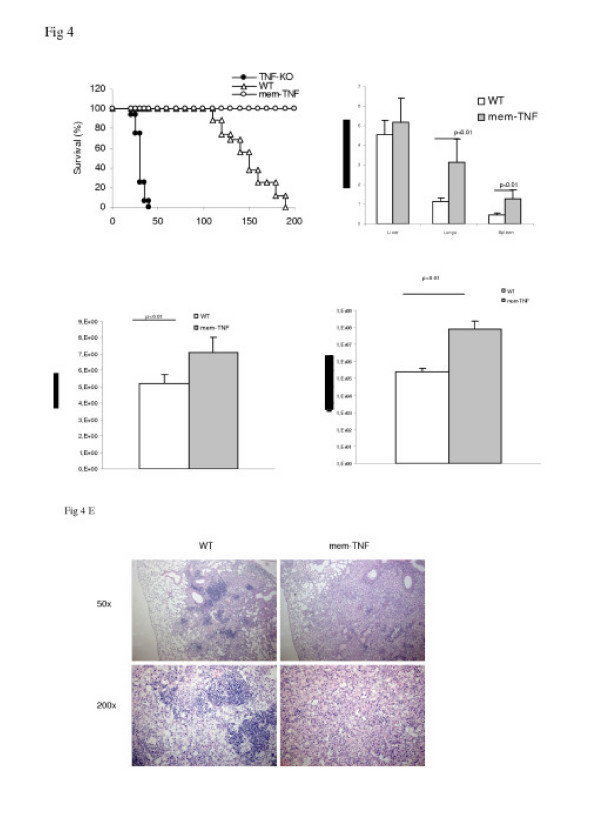
Mem-TNF mice succumb of uncontrolled chronic Mtb infection after 4–6 months. Survival (A) of infected mice (Mtb 100 CFU given by intranasal route), data two independent experiments (n = 16 per group). Organs weights (B) and bacterial loads (CFU) in lungs (C) and spleen (D) were determined at 112 days after infection. The results are expressed as the mean ± SD (n = 6 per group). Microscopic changes of the lung from mem-TNF and WT mice at 112 days (E). Microscopic analysis of the lung reveal a more abundant macrophages and lymphocyte infiltration in mem-TNF mice with confluent foci and less defined granulomatous lesions. Representative haematoxylin and eosin stained lung sections at low (50×) and high power (200×) are shown (n = 6 per group).